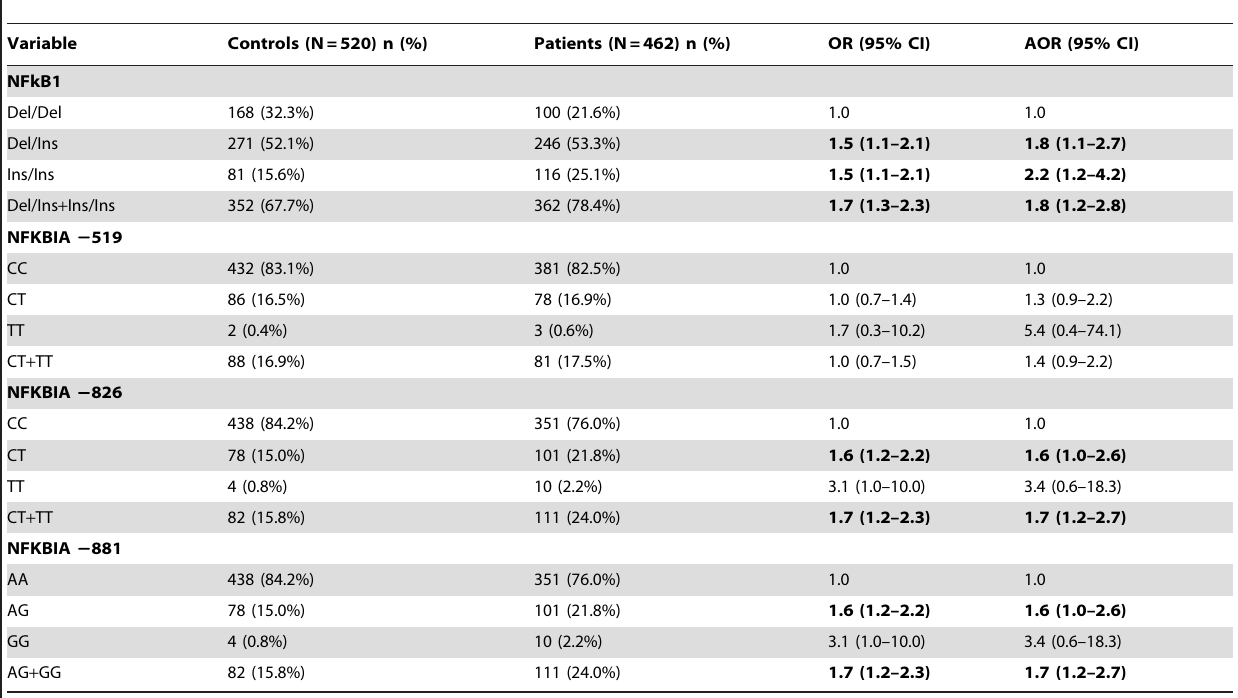
Table 2. Distribution frequencies for NFKB and NFKBIA genotypes in 520 controls and 462 oral cancer patients.